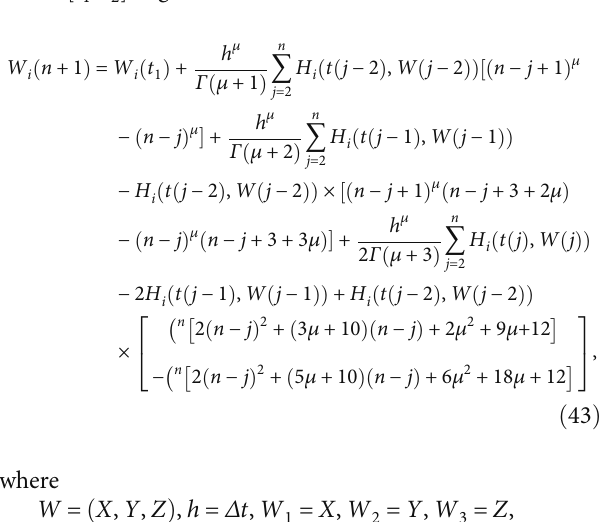
and fractional order μ = 0 : 98 5